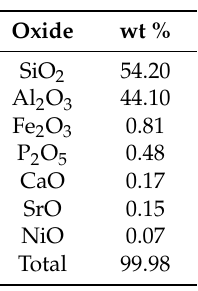
Table 3. Chemical composition of calcined